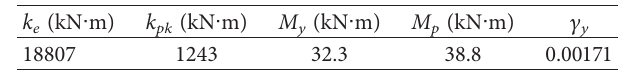
Table 5: Spring properties of the KCM.